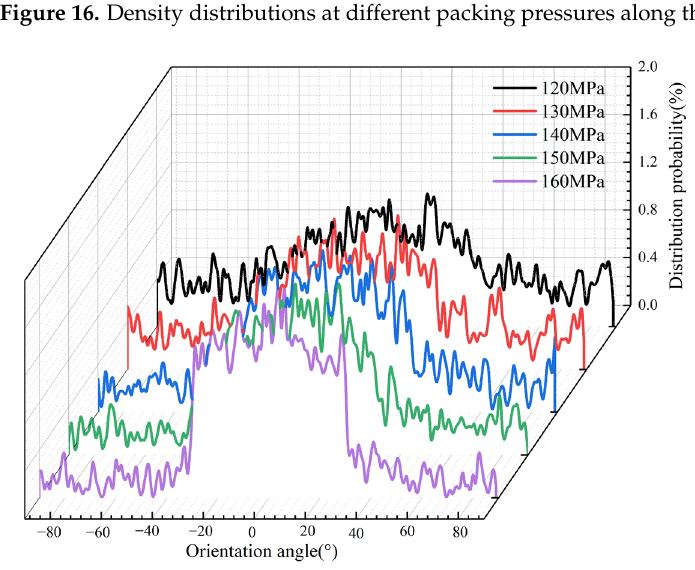
Figure 17. Orientation angle distributions of PP at different packing pressures along the flow direc- tion.